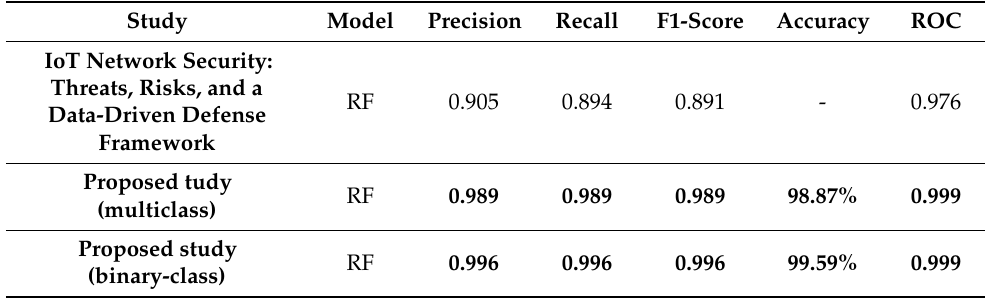
Table 12. Comparison with benchmark